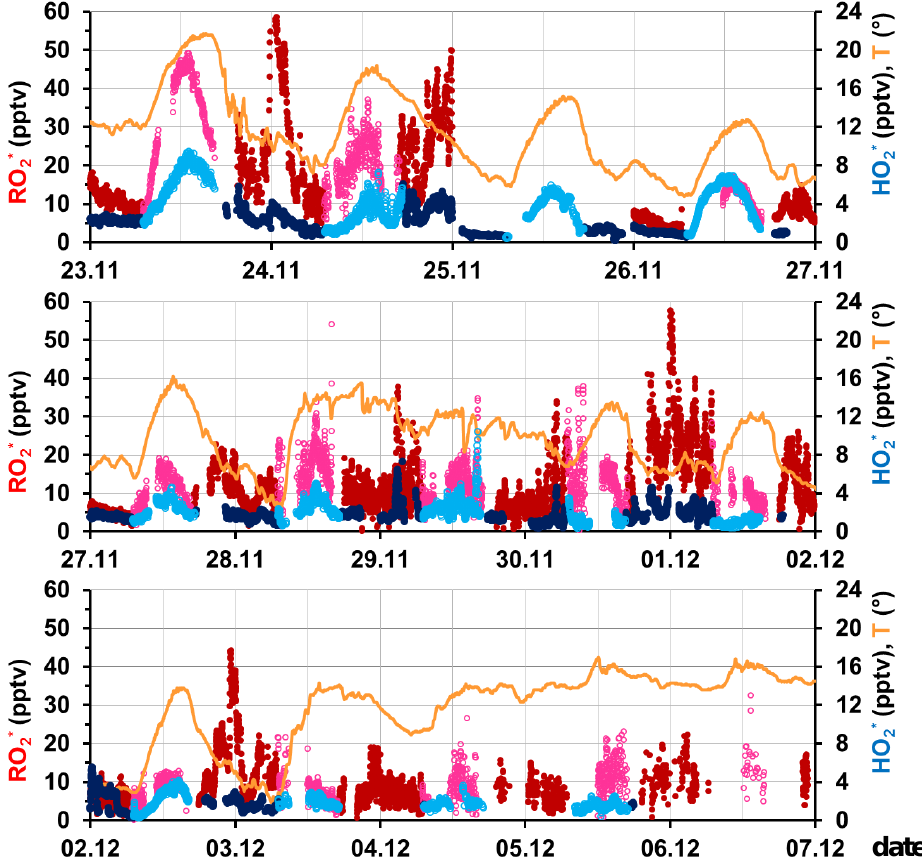
Fig. 4. DUALER-RO ∗ and HORUS-HO ∗ measured during DOMINO. Daylight (06:00–17:00UTC) and nighttime periods are marked sep- 2 2 arately. Temperature is depicted as additional